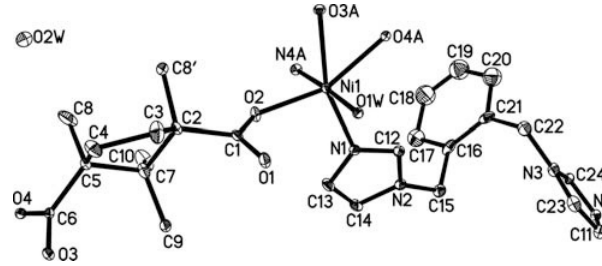
Table 1. Data collection and handling.